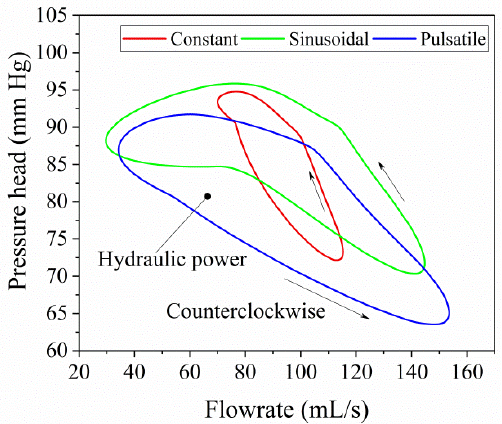
Figure 11. H–Q curve loop of the impeller with three speed patterns. Arrows indicate the trend of the blood flow rate and pressure changes with the impeller speed. The closed curve represents the hydraulic power consumed by the blood pump in a cardiac cycle.